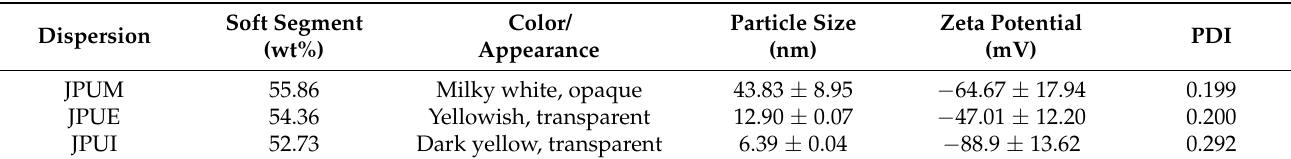
Table 5. The appearance, particle size, and zeta potential of JPUM, JPUE, and JPUI.